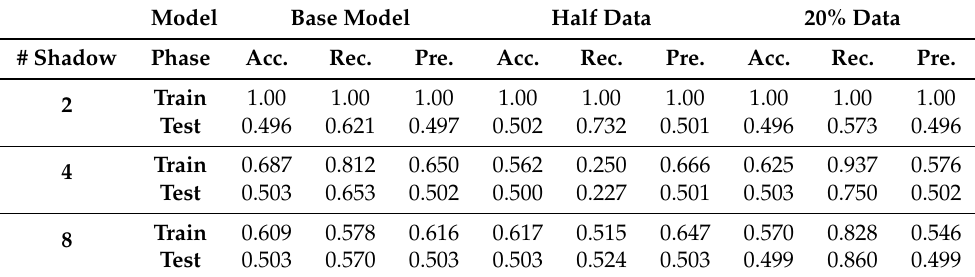
Table 7. Membership inference attacks results on Fashion-MNIST